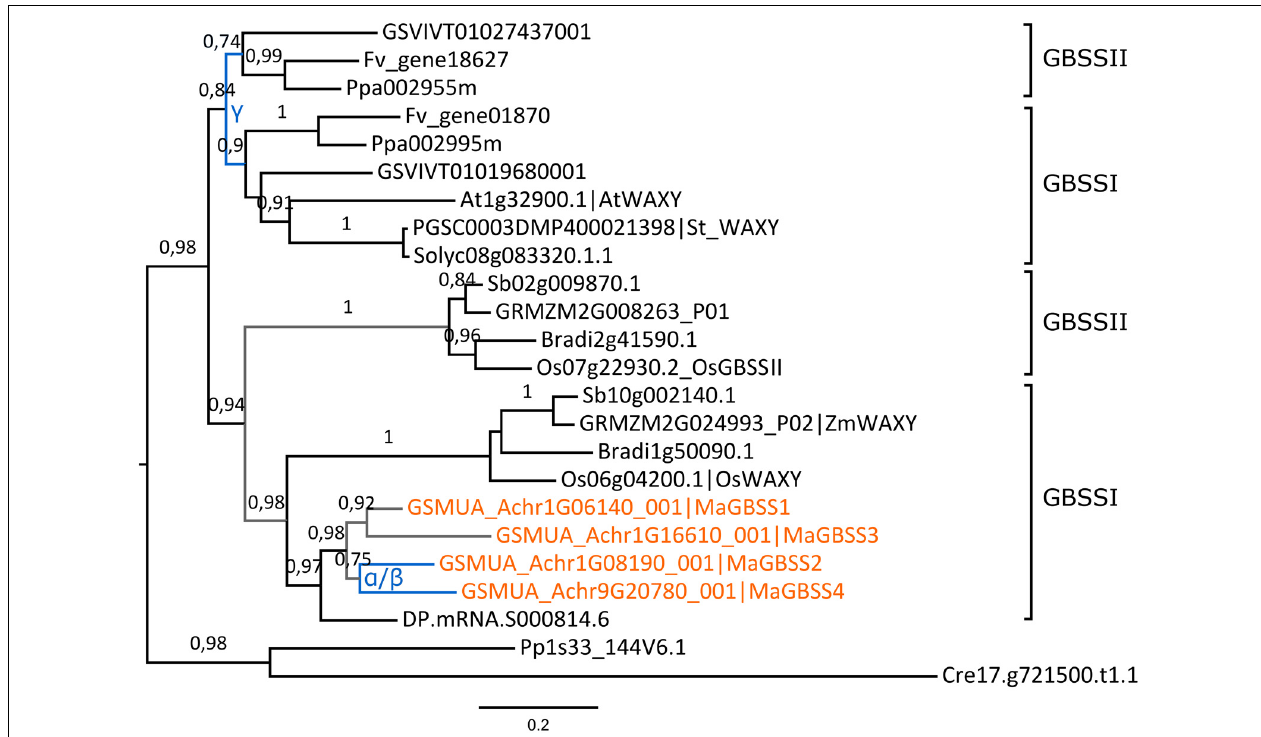
FIGURE 3 | Expansion of the GBSS family in banana. The maximum likelihood tree of GBSS predicted proteins was rooted using Chlamydomonas reinhardtii (Cre) and Physcomitrella patens (Pp) GBSS sequences. Branch supports > 0.70 (aLRT statistics with SH–like procedure) are indicated. Grapevine (GSVIV), tomato (Solyc), potato (PGSC), woodland strawberry (Fv), Arabidopsis (At), peach (Ppa), Brachypodium (Bradi), rice (Os), maize (GRMZM), Sorghum (Sb), date palm (DP) and banana (GSMUA) identifiers are indicated (in brown for banana). Branches are colored according to gene duplication modes: WGD (blue) and unknown (gray). Black branches correspond to speciation events. Banana WGD events identified using reconstructed ancestral blocks are indicated. The gamma duplication is inferred based on synteny blocks in PGDD. The scale bar represents the estimated amino acid substitutions per site.